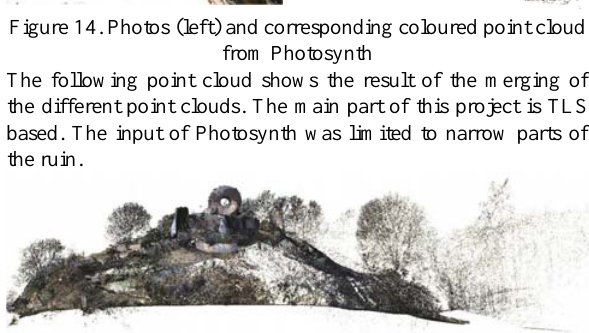
Figure 15. Point clouds merged in a panoramic view. The so- called “Eye of the Witch” is visible on the top of the